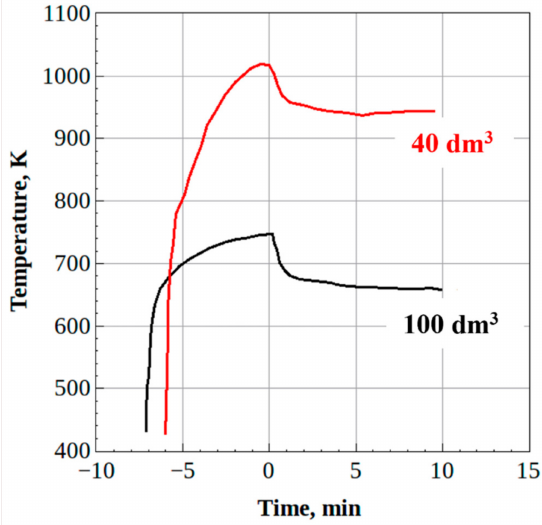
Figure 5. Time histories of the syngas temperature in the outlet tube for the 100- and 40-dm 3 reactors with the PD gun operating at f = 1 Hz. Time point 0 corresponds to the start of waste oil supply to the reactor with G = 2 g/s (100-dm 3 reactor) and 4 g/s (40-dm 3 reactor); P ≈ 0.1